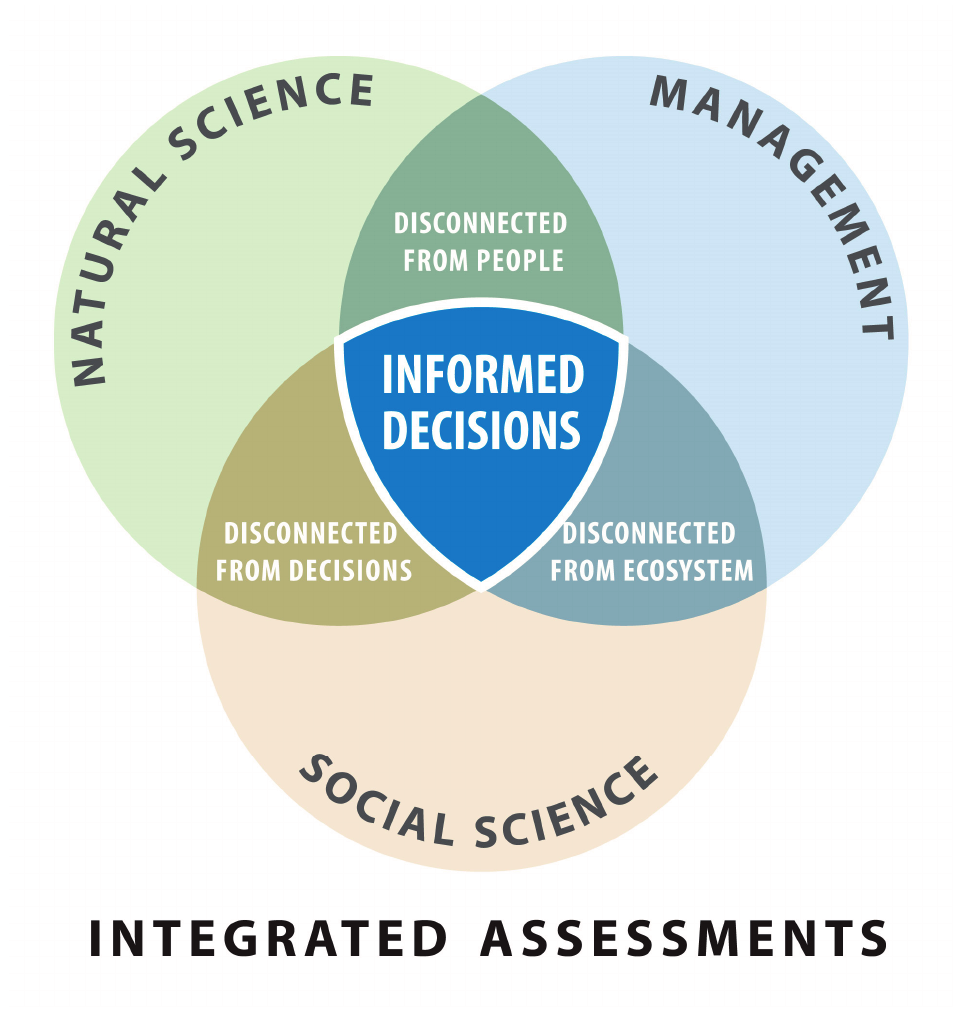
Figure 1. An Integrated Assessment brings together groups normally separated along disciplinary or sectoral lines to facilitate multi-disciplinary dialogue and work towards building consensus. Figure is reproduced with permission from the Michigan Sea